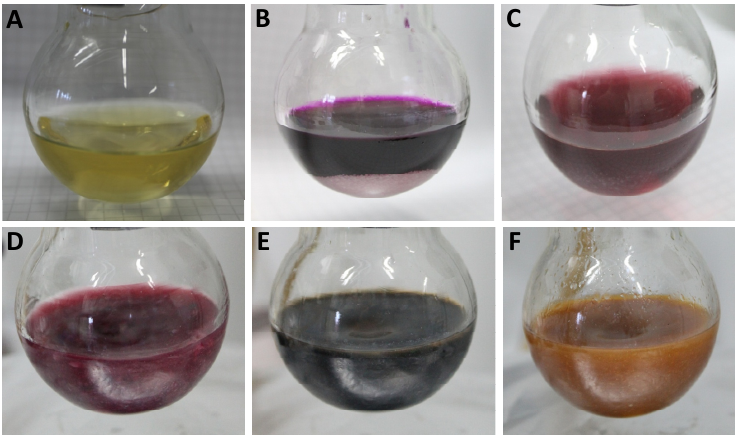
Figure 2. Aspect of the solutions in the first moments of syntheses: ( A ) ethanol solution containing PyQAs; ( B ) ethanol solution with PyQAs and zinc(II) acetate; ( C ) color change of solution (B) after heating and stirring for 10 minutes; ( D – F ) color change upon the addition of potassium hydroxide.